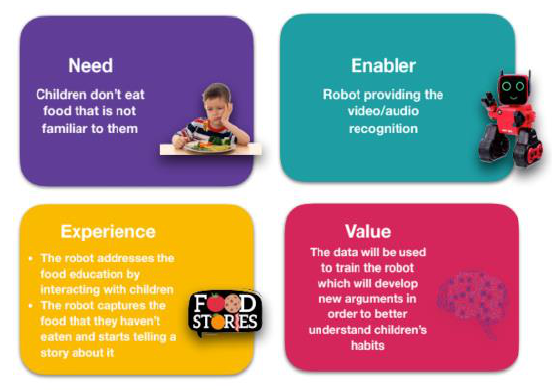
Fig. 12. Example of a ‘wrong’ use of tech functional scenario: the enabler is a technology and not a function.